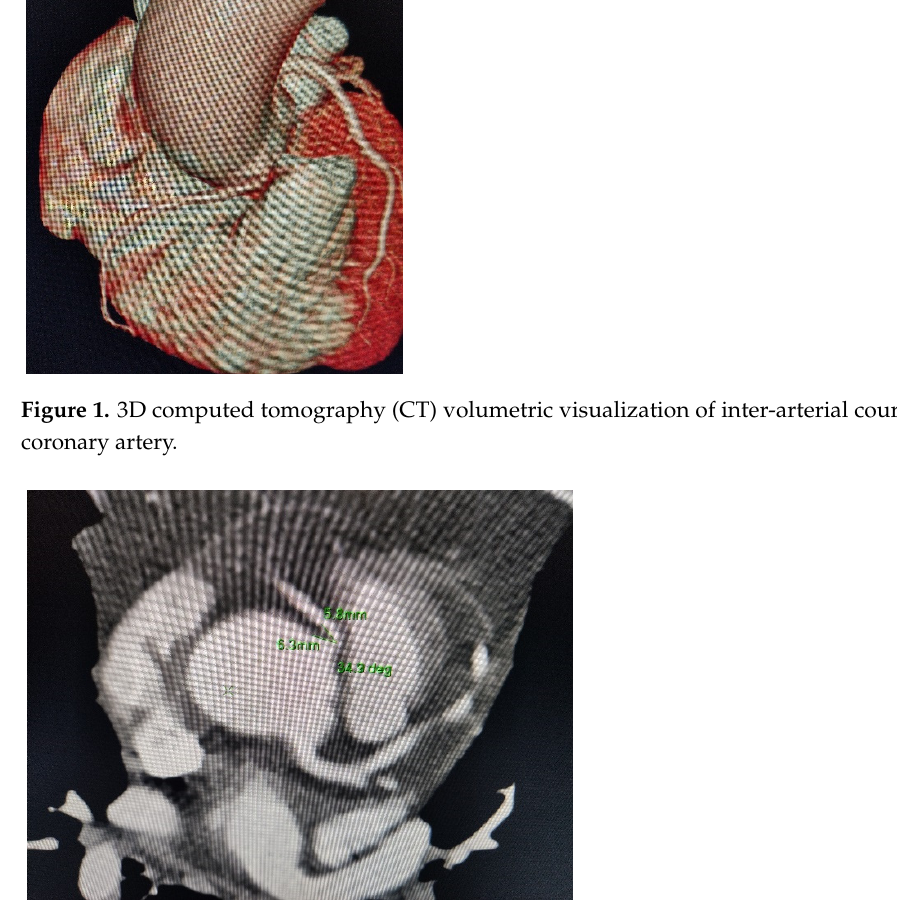
Figure 2. Maximum intensity projection visualization depicts the origin of a coronary artery with an acute angle (<50 ◦ ), and then its passage between the aorta and the pulmonary artery, both dilated.